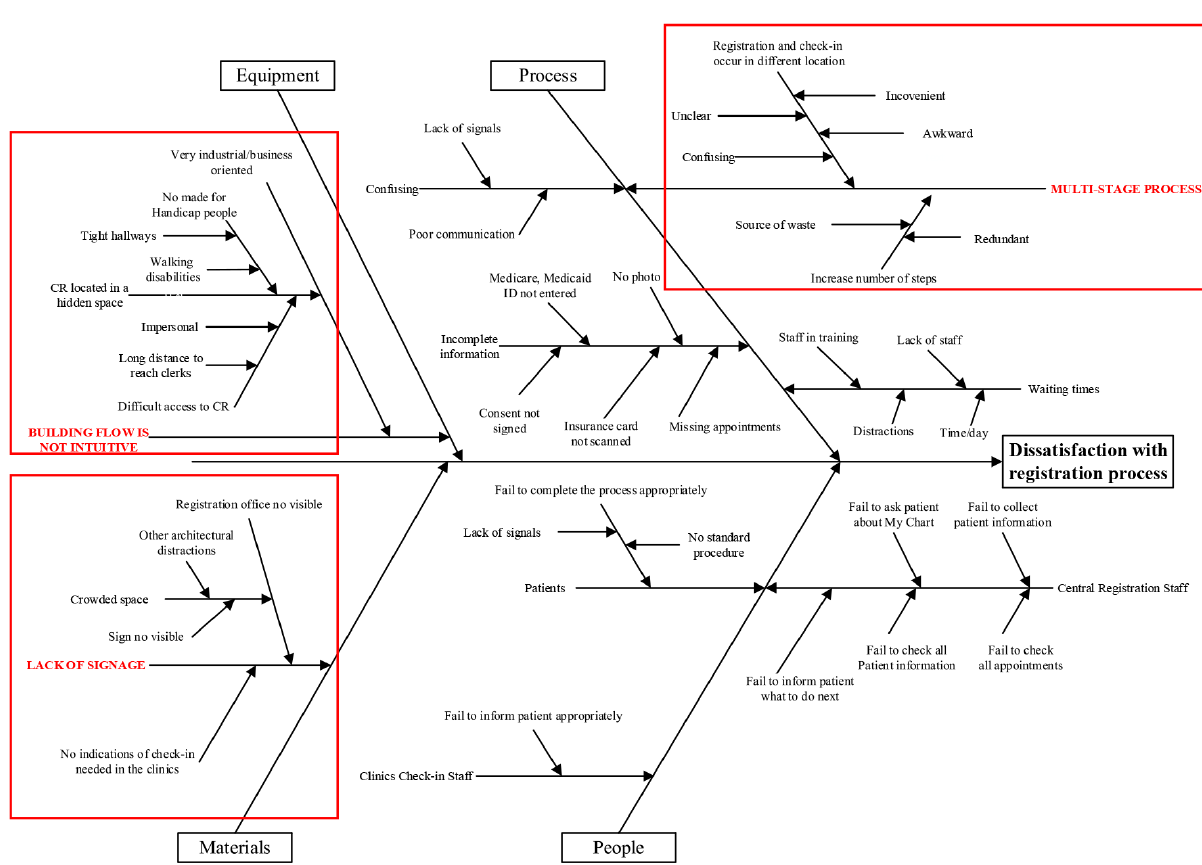
Figure 4. Fishbone diagram of dissatisfaction with the central registration